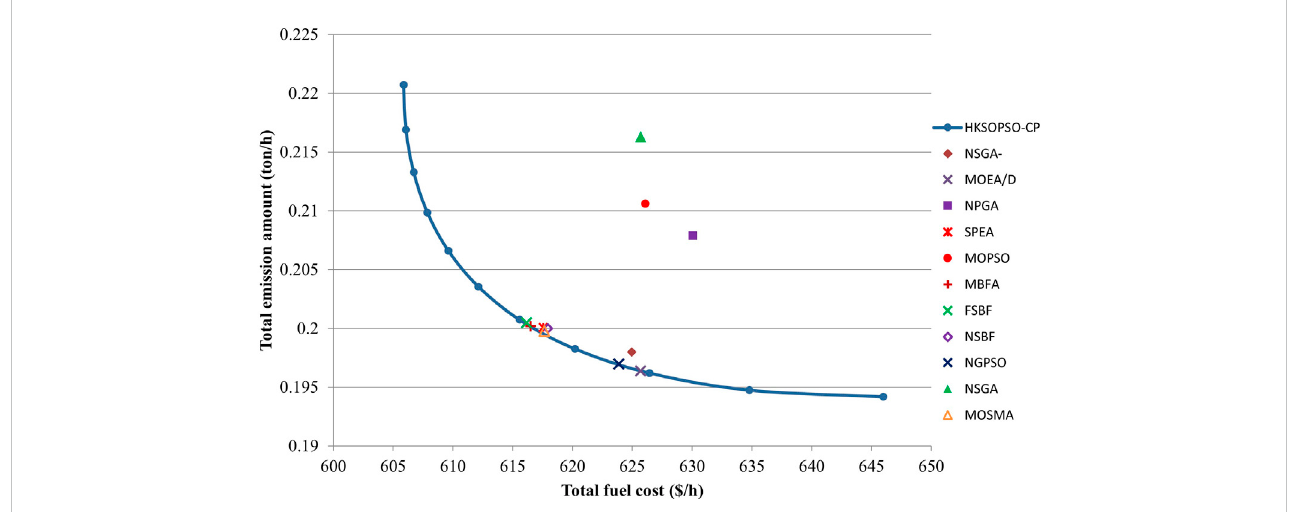
FIGURE 4 Case 1: Solutions generated by the HKSOPSO-CP algorithm, and the best compromise solutions provided by other